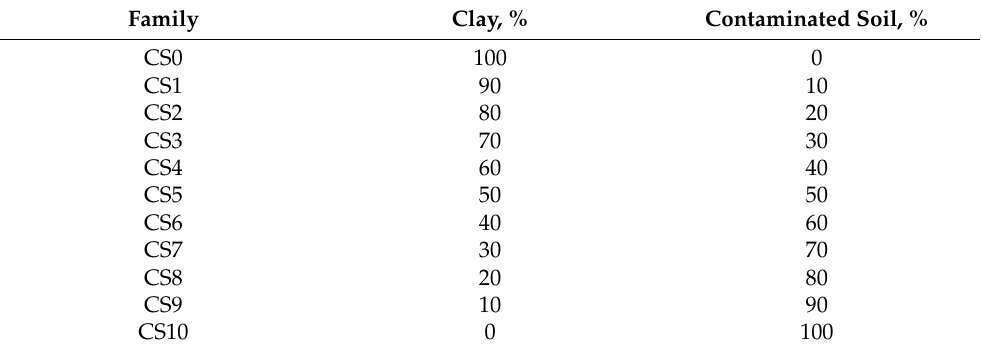
Table 1. Families of conformed ceramics with different combination percentages of clay and contami- nated soil. Family Clay, % Contaminated Soil, % CS0 100 0 CS1 90 10 CS2 80 20 CS3 70 30 CS4 60 CS5